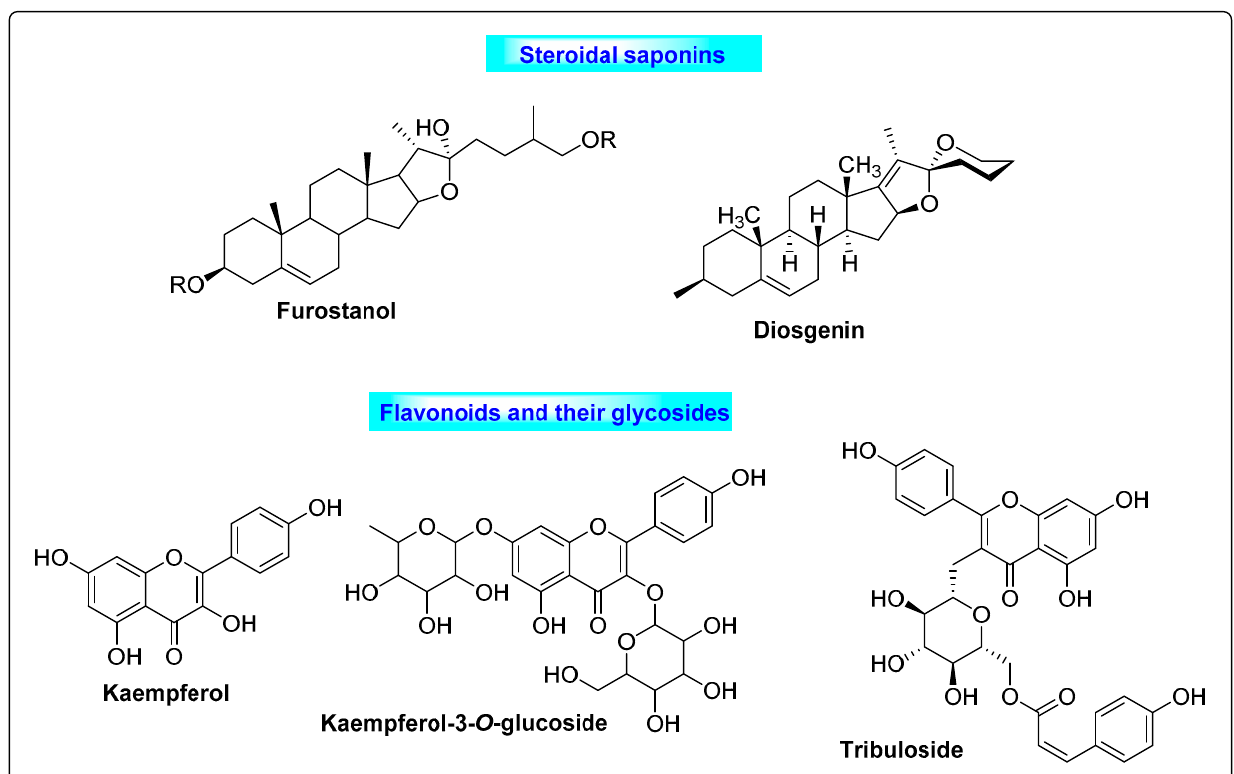
Figure 19. Saponins and flavonoids present in Tribulus terrestris that have positive effects on PCOS by inducing ovulation.